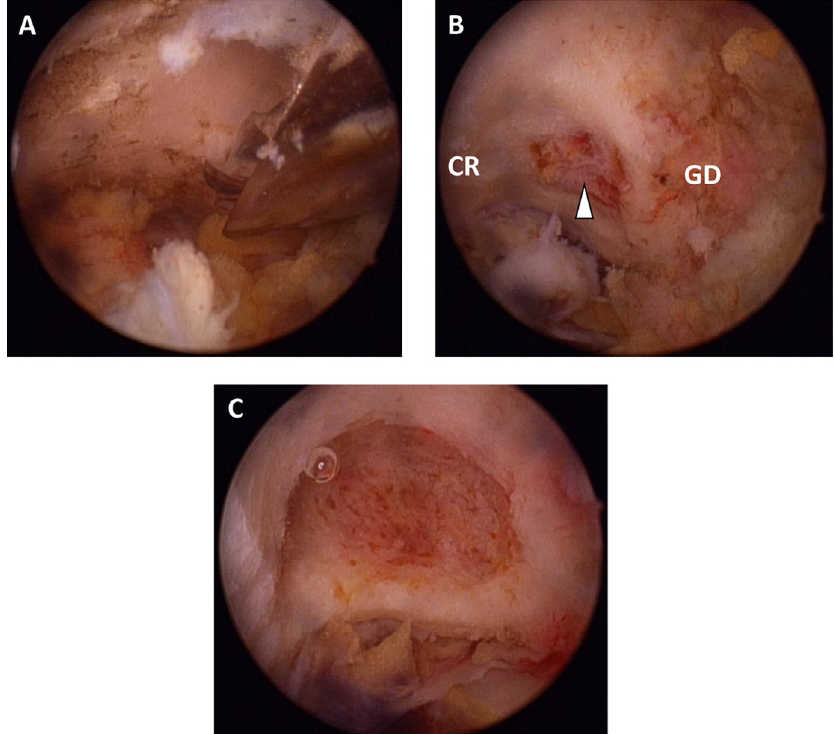
Figure 4. Arthroscopic images of excision of osteoma. (A) De-roofing of the lesion by arthroscopic burr, (B) after removal of anterior wall revealing the hypervascular nidus (arrowhead) at the base of coracoid (CR) medial to the glenoid (GD), (C) after complete removal of lesion there is healthy cancellous bone at the